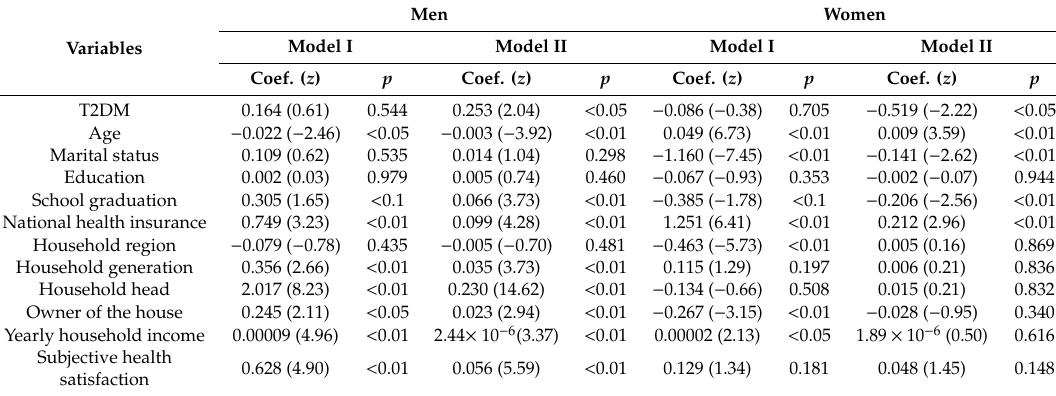
Table 3. E ff ect of T2DM on employment status by gender using probit regression and two-stage least squares(2SLS)